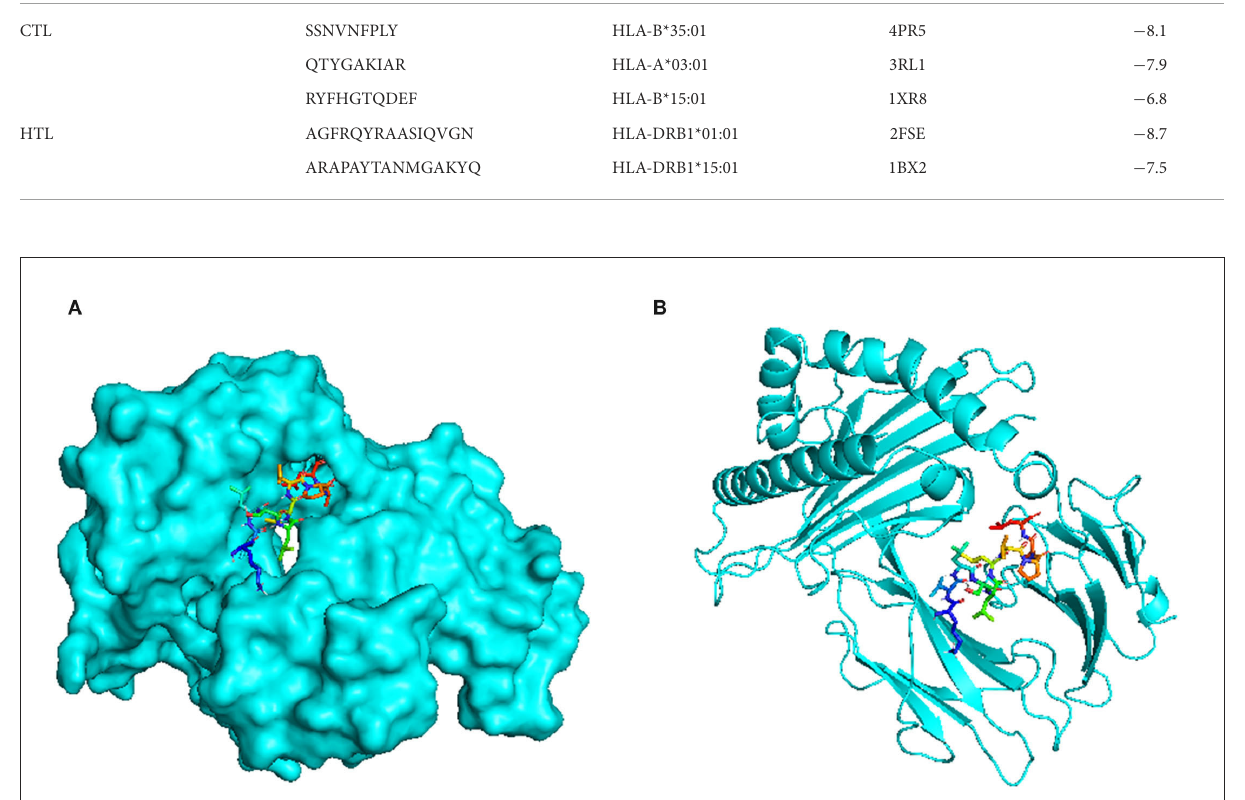
FIGURE3 Docking visualization between the epitope AGFRQYRAASIQVGN and its corresponding MHC allele (HLA-DRB1*01:01) using the PyMol software: (A) Surface view (B) Cartoon view.